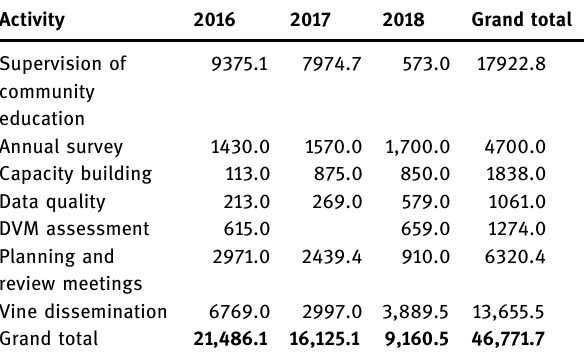
Table 2: M&E costs across 3 years ( cost in USD ) Activity